Question: Describe this figure in one sentence.
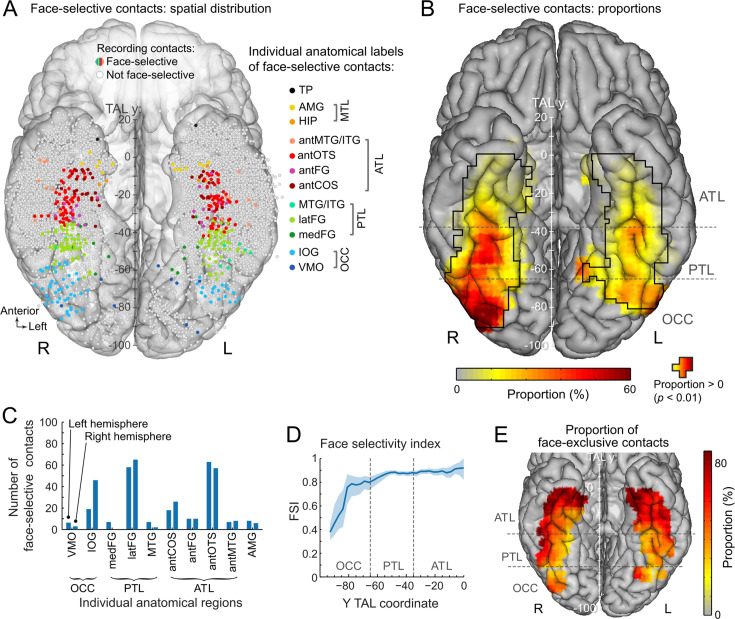
Answer: Spatial organization and increase in abstraction of face-selective HFB activity inVOTC. ( A ) Map of all VOTC recording contacts across the 140 individual brains displayed in the Talairach space in a transparent reconstructed cortical surface of the Colin27 brain (ventral view). Each circle represents a single recording contact. Face-selective contacts are color-coded according to their anatomical location in the original individual anatomy. White-filled circles correspond to contacts without significant face-selective activity. Values along the y-axis of the Talairach coordinate system (postero-anterior) are shown near the interhemispheric fissure. ( B ) VOTC maps of the local proportion of face-selective contacts relative to the number of recorded contacts. Black contour lines delineate local proportions significantly above zero ( p <0.01, percentile bootstrap). ( C ) The number of face-selective contacts is shown for each anatomical region (region defined in each individual participant) and hemisphere. ( D ) Face-selectivity index (FSI) along the postero-anterior axis collapsed along the X dimension (medio-lateral). The shaded area shows the 99% confidence interval computed using a percentile bootstrap. ( E ) Map of the proportion of face-exclusive (i.e. face-selective without significant response to nonface-objects at 6 Hz and harmonics) relative to face-selective contacts across VOTC.